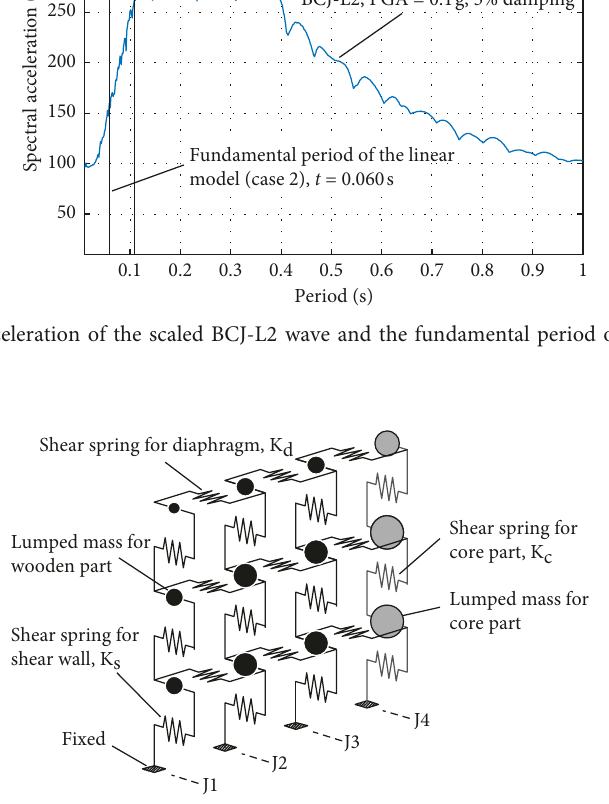
Figure 5: Linear model to calculate the fundamental mode of vibration for the MRS Table 1: Structural weight ( N ) and shear stiffness ( N /mm) used in DELF and MRS. Value( N , N /mm)